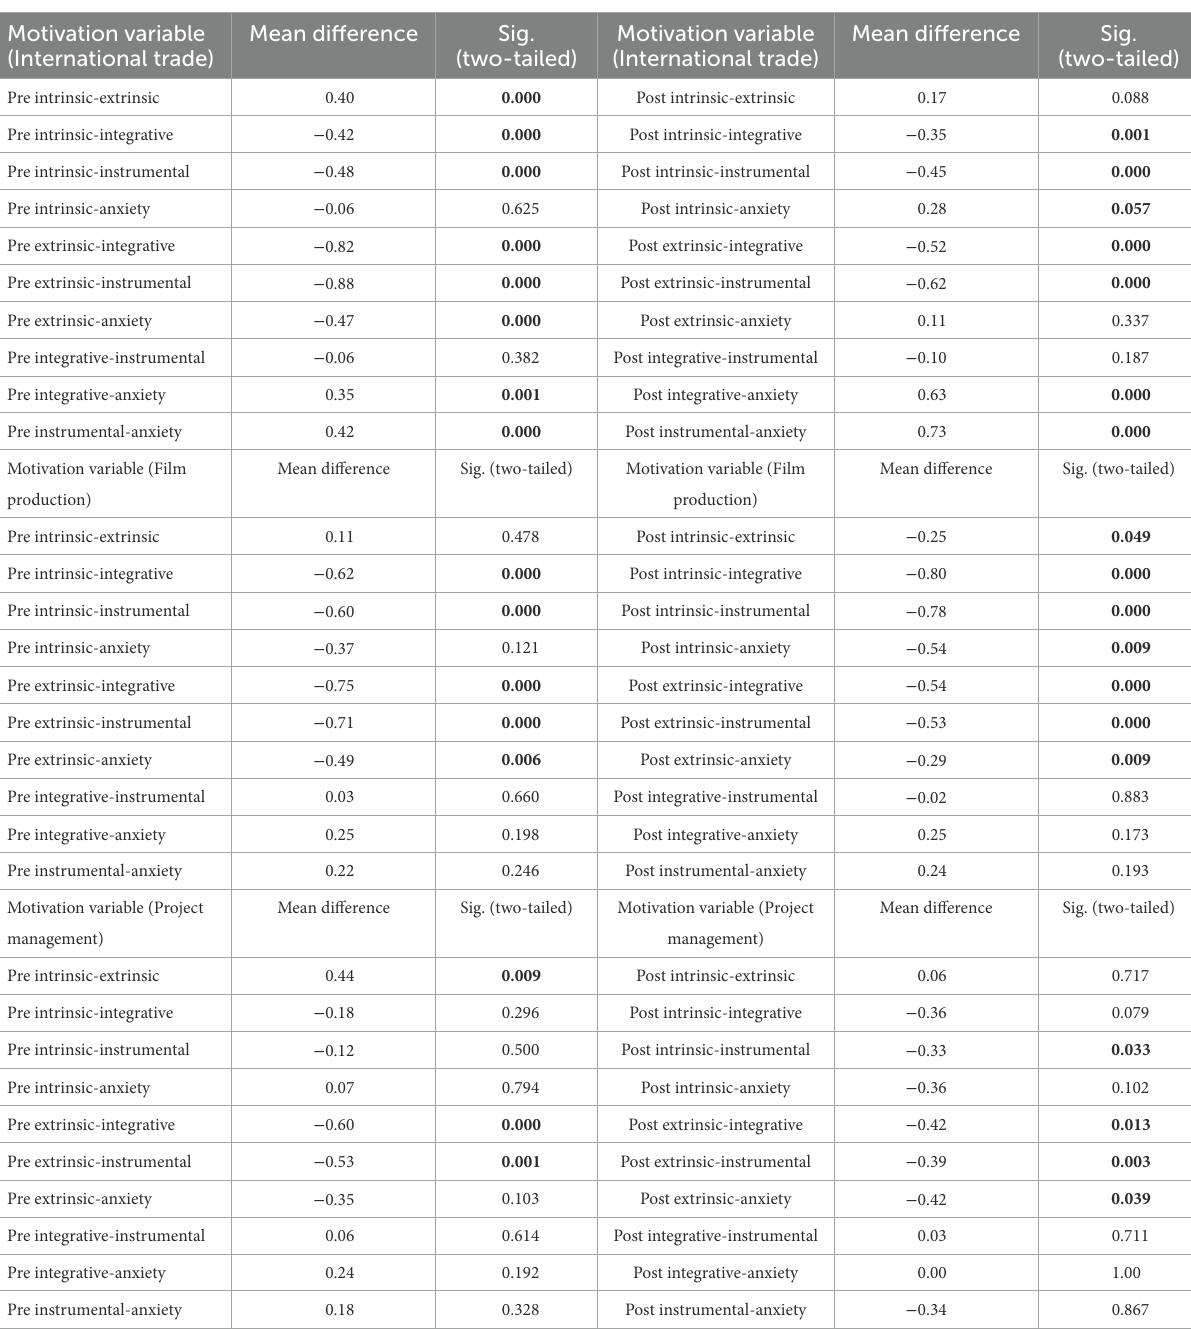
TABLE 3 Pre-post student questionnaires (motivation variable